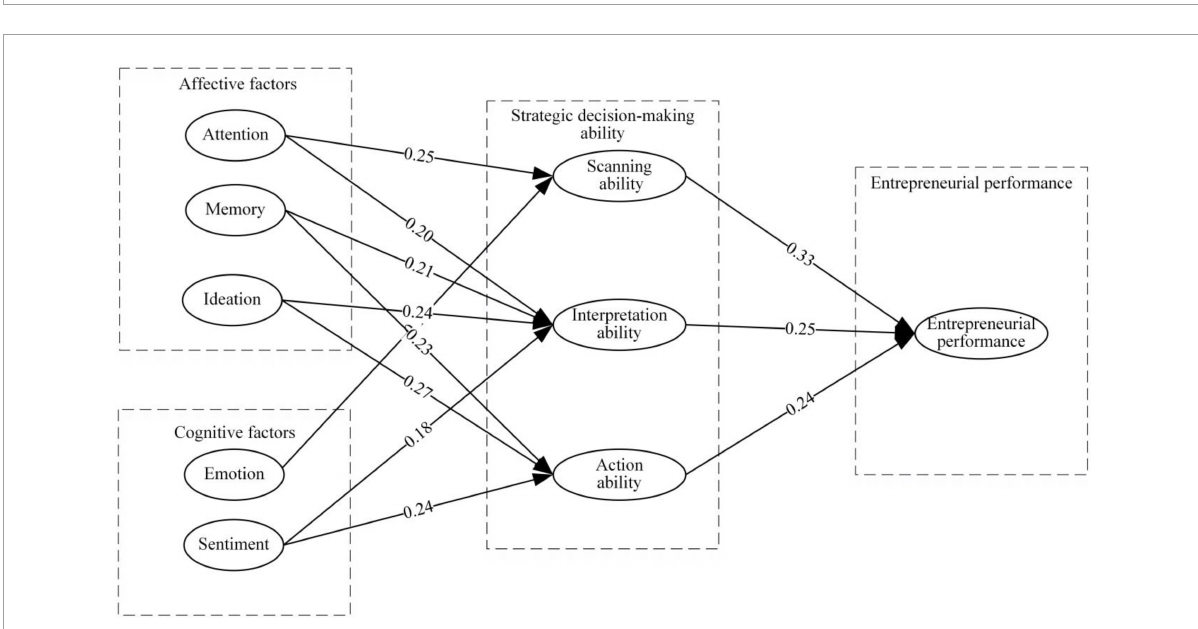
FIGURE6 Influencing factors model of strategic decision-making capacity based on structural equation modeling – artificial neural network